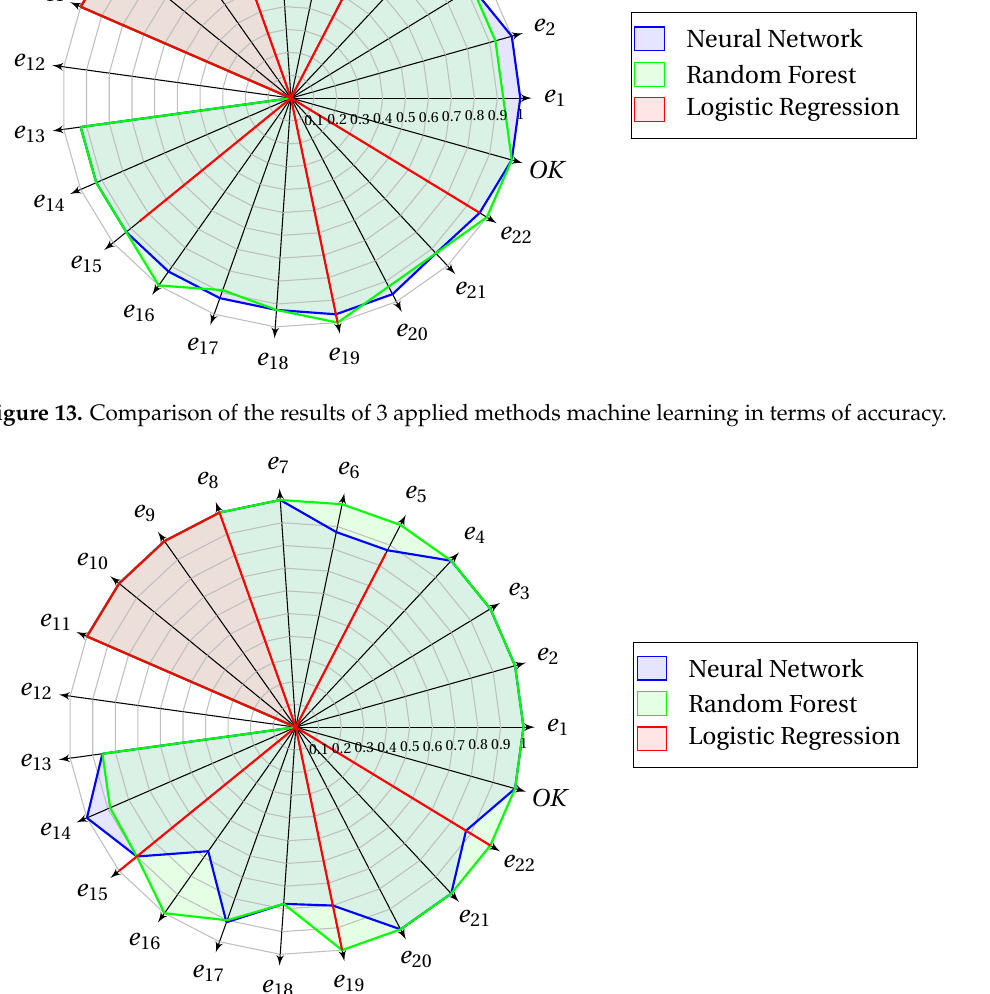
Figure 14. Comparison of the results of 3 applied methods machine learning in terms of precision.